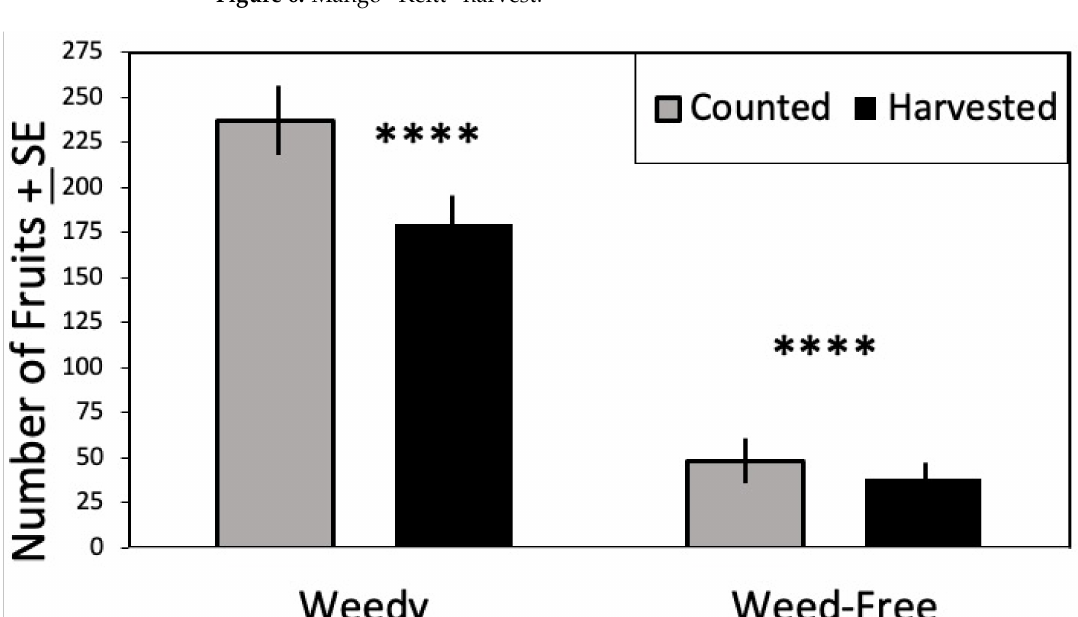
Figure 7. Mean number of mango fruit harvested or counted by treatment ± SE. Significant difference indicated above each Treatment **** p ≤